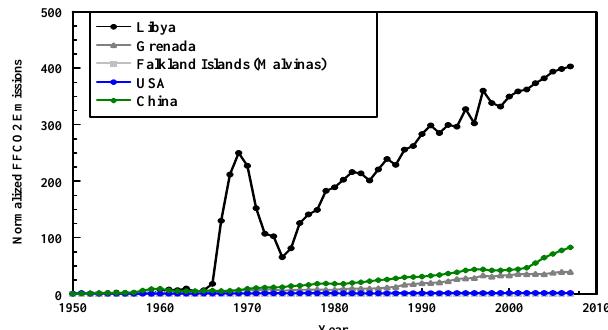
Fig. 6a. Comparison of FFCO2 emissions from two CarbonTracker (CT) simulations for the CT Euarasia temperate region. FFCO2 emissions were revised and updated between the two CT simulations. Data from Jacobson (unpublished data).